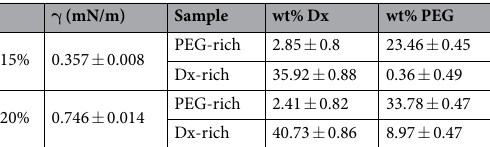
Table 3. Physical properties of 15%/15% and 20%/20% w/w PEG/Dx